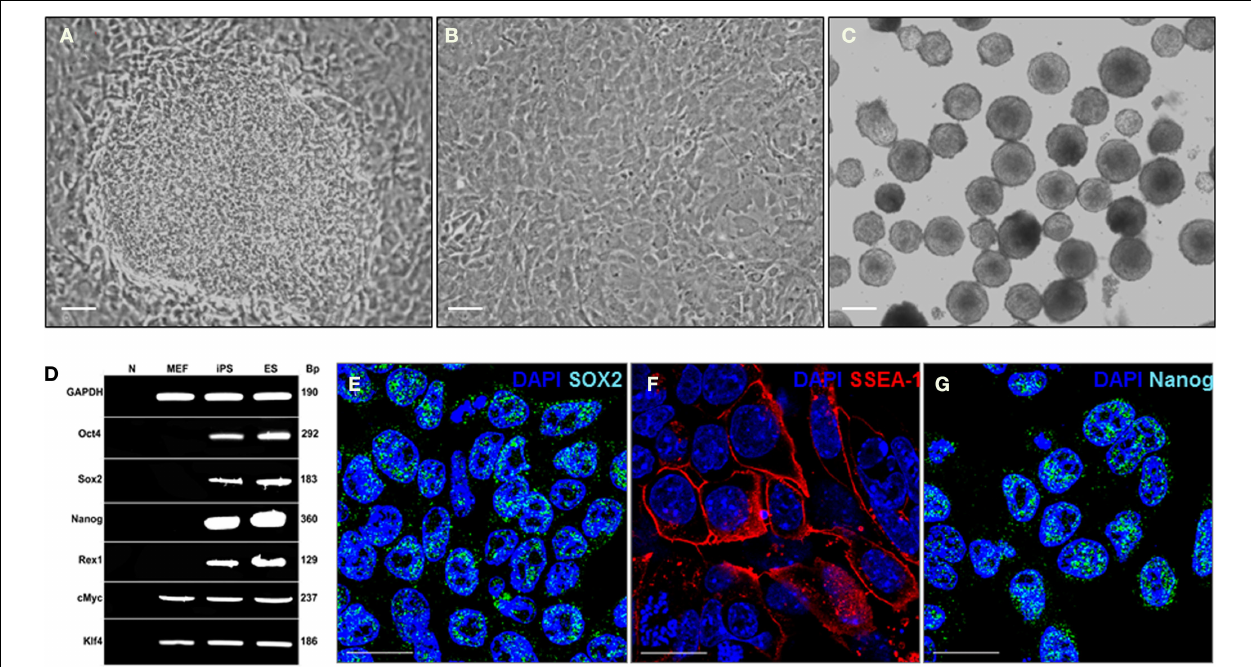
FIGURE 1 | Mouse iPS cells have cell morphology and staining characteristics of mouse ES cells . (A) MEFs formed multilayered, tightly packed cells with well-defined borders after infection with the STEMCCA Lentivirus. This figure shows a representative phase contrast image of a single mouse iPS cell colony taken at 12days post-infection. Scale = 200 µ m. (B) Control well of MEFs not infected with the STEMCCA Lentivirus. Cells remain in a monolayer culture with no ES cell-like colonies observed. This is a representative phase contrast image taken at the same